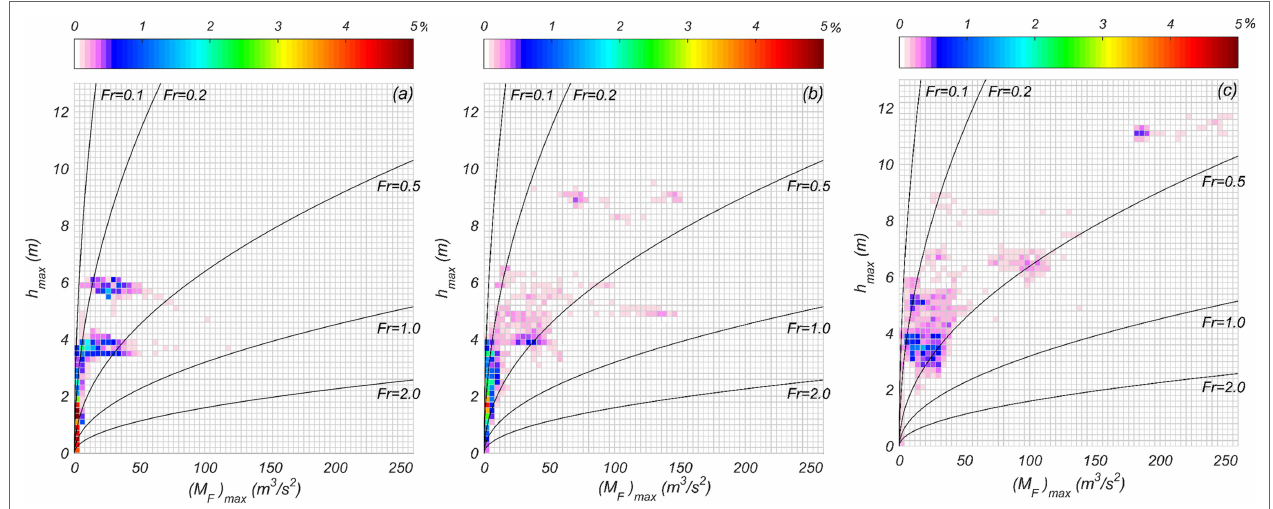
FIGURE 15 | Spatial distribution of joint h max and ( M F ) max with Froude number ( Fr ) for (A) 500, (B) 1,000, and (C) 2,500-year events.